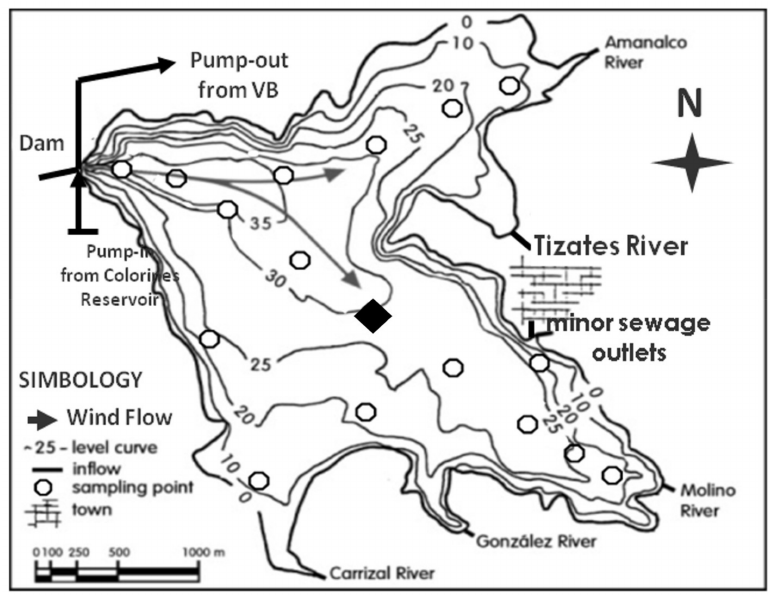
Figure 1. Bathymetric map of Valle de Bravo (VB) reservoir lake (modified from [15]) showing sampling stations, main inputs (rivers and sewages), and water withdrawal route. Central station sampled throughout the studied period indicated by (cid:7) . Depth contours in m below the maximum level of the lake. Daily wind pathways over both arms are also indicated ( (cid:58)